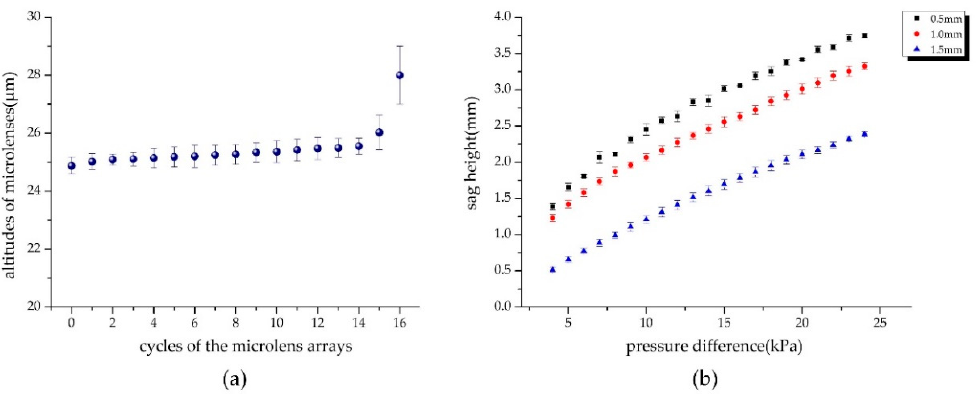
Figure 5. Result of morphology measurement experiment: ( a ) altitudes of pressed polymeric MLAs with different diameters from 0th to 16th cycles; ( b ) deformation of PDMS membranes with different thickness under pressure from 4–24 Kpa.